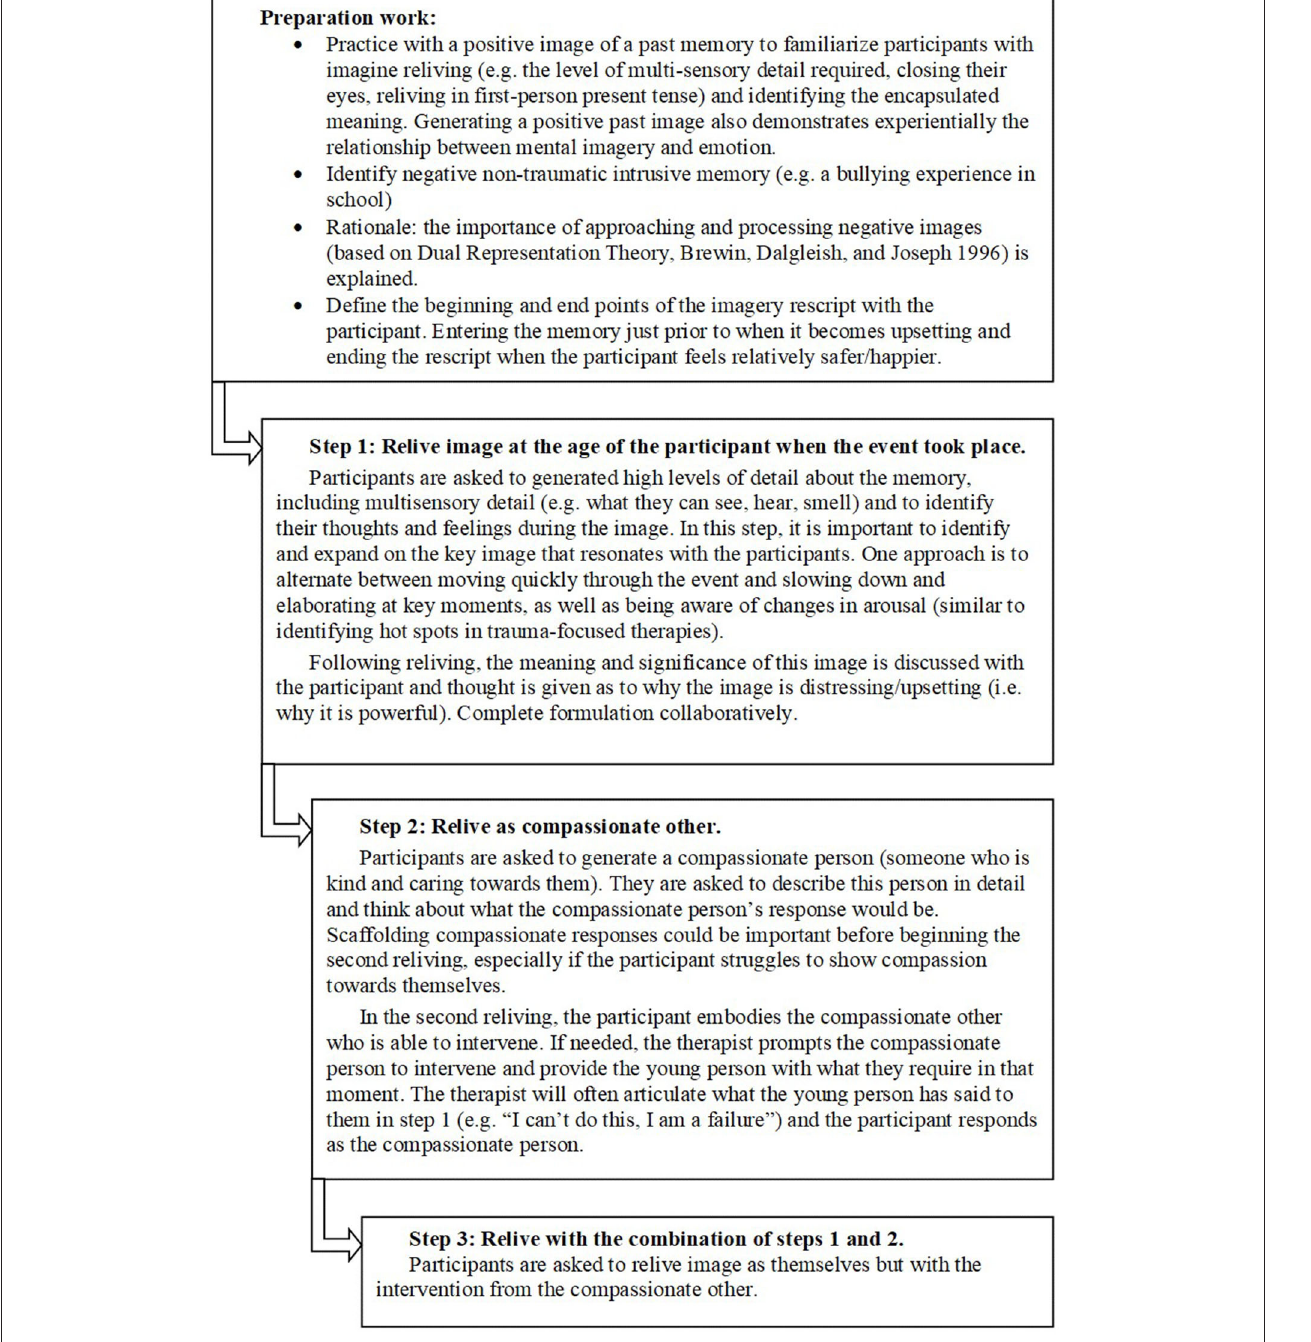
FIGURE 1 | Protocol for imagery